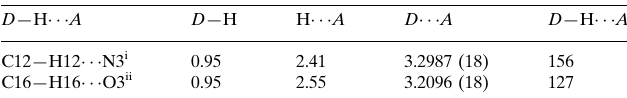
Hydrogen-bond geometry (A˚ , (cid:2)